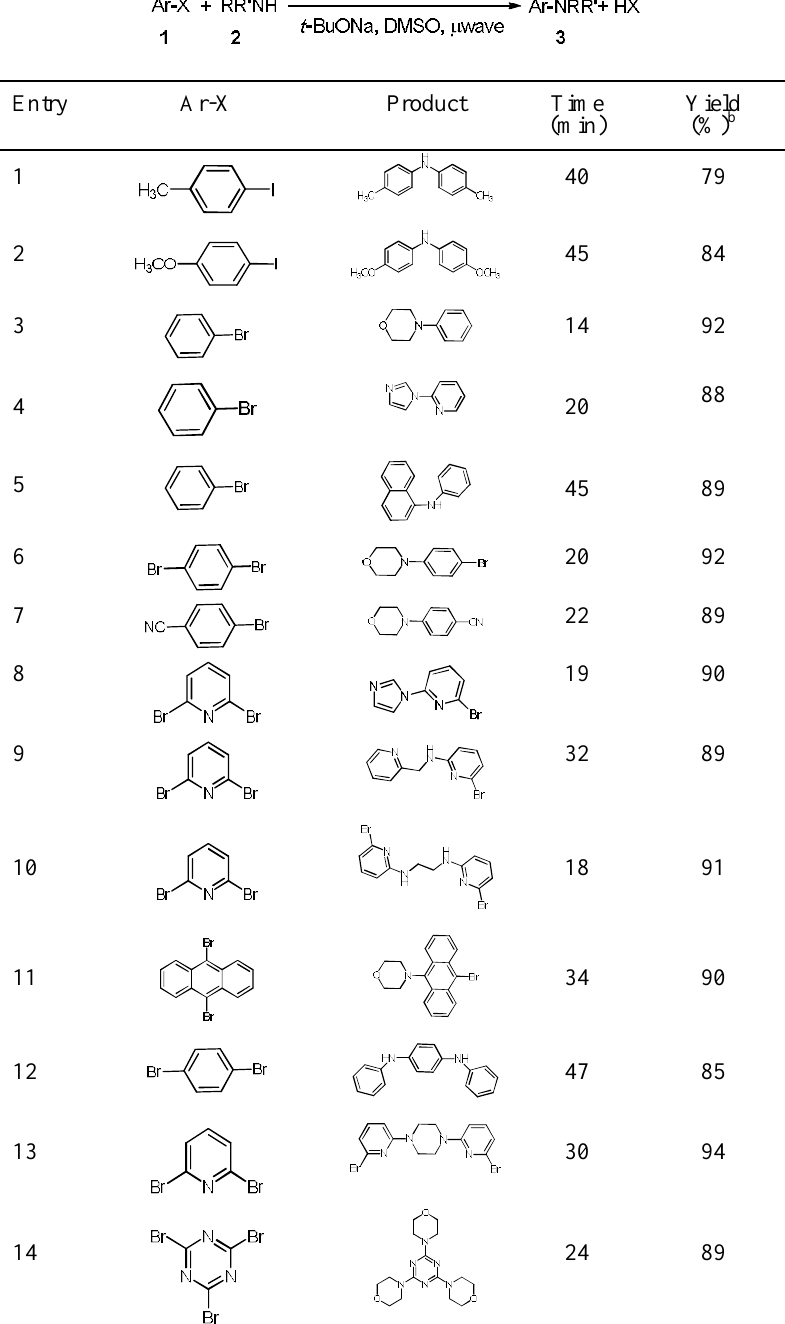
mmol), DMSO (1 ml) in the presence of the catalyst containing 0.002 mol% Pd. b Isolated